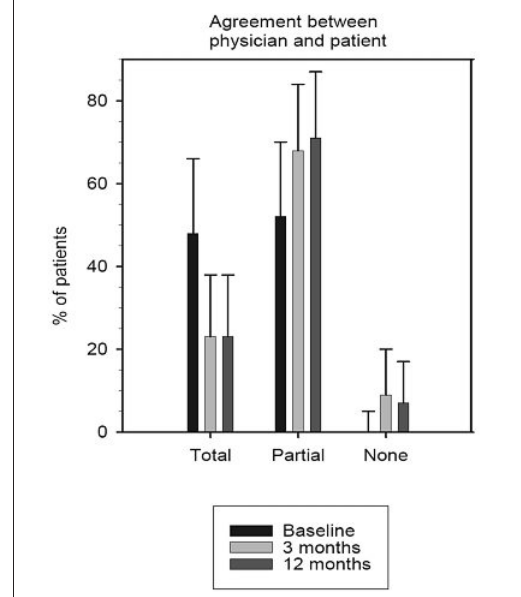
Agreement on symptoms as rated by physician (chart) and patient (ques- tionnaire) before and 3 and 12 months after surgery (error bars are exact 95% confi- dence intervals).